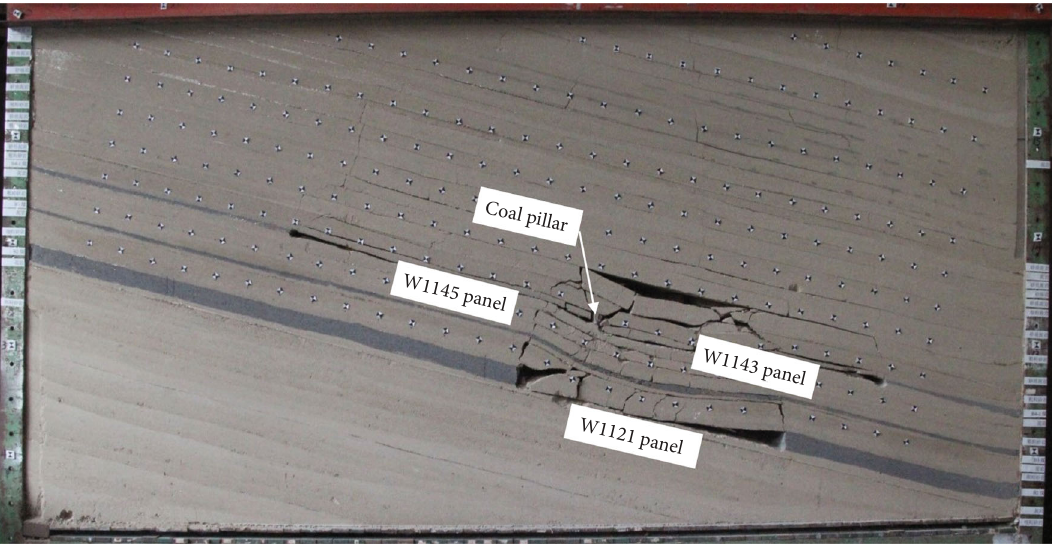
Figure 9: Characteristics of overlying strata in W1121working face